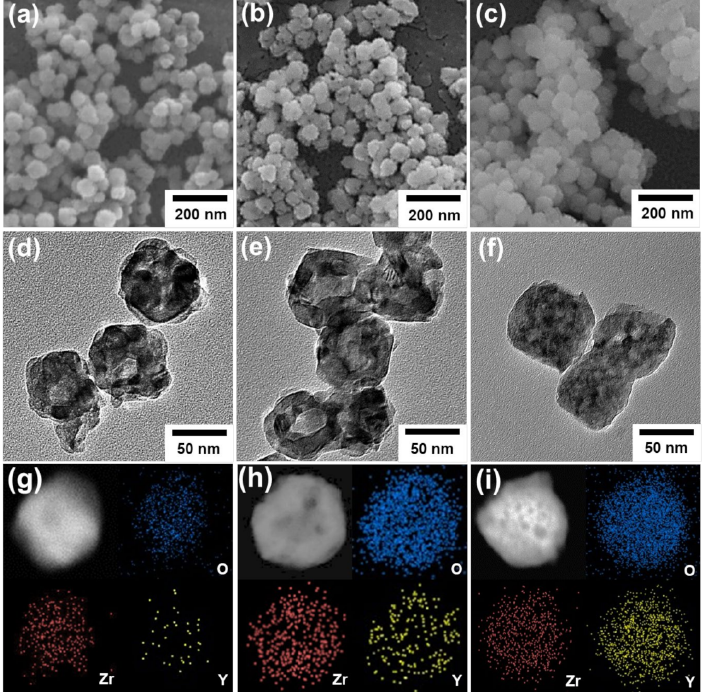
Figure 2. FE-SEM images ( top ), TEM images ( middle ), and STEM-EDX mapping images ( bottom ) of the YSZ nanospheres: ( a , d , g ) 3YSZ, ( b , e , h ) 8YSZ, and ( c , f , i ) 30YSZ.